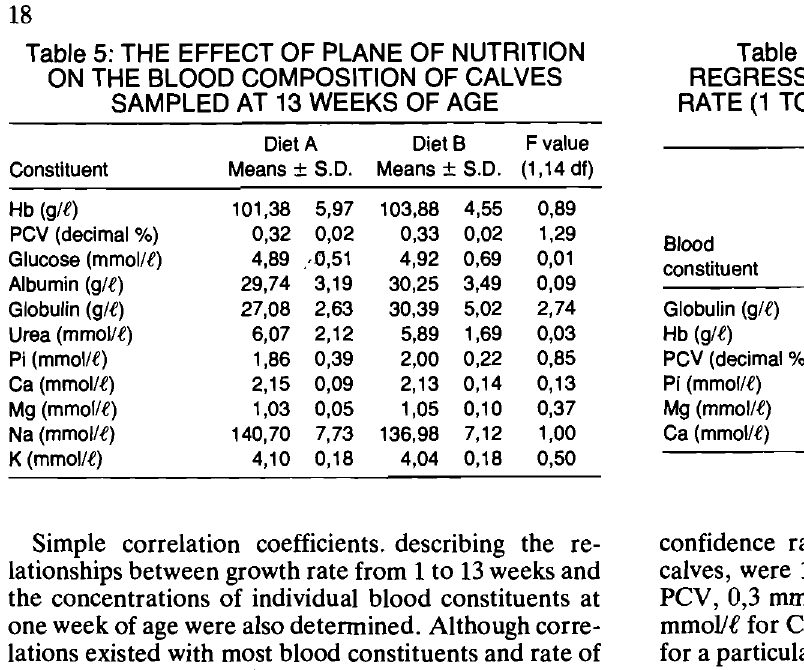
Table 7: SUMMARY OF THE MULTIPLE Table 5: THE EFFECT OF PLANE OF NUTRITION REGRESSION ANALYSIS RELATING GROWTH ON THE BLOOD COMPOSITION OF CALVES RATE (1 TO 13 WEEKS) WITH BLOOD ANALYSIS SAMPLED AT 13 WEEKS OF AGE AT ONE WEEK OF AGE Diet A DietB Fvalue Differences in growth Constituent Means ± S.D. Means ± S.D. (1,14 df)